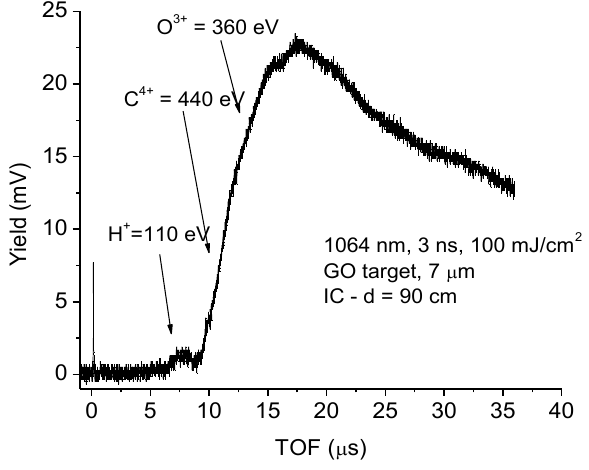
Fig. 3. IC-TOF spectrum of ions emitted during the GO laser